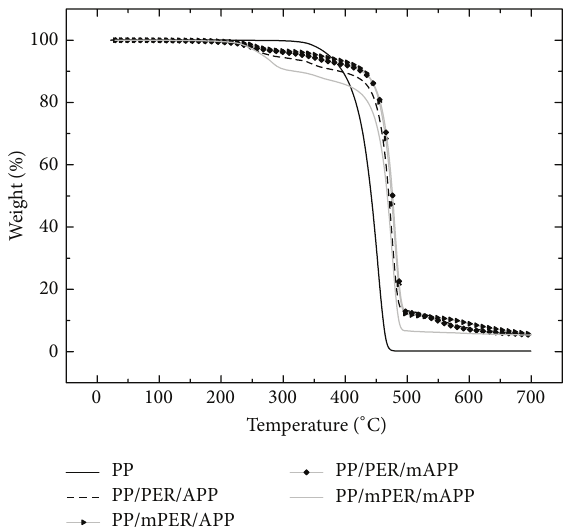
Figure 3: TG curves of neat PP and four intumescent flame retarded PP mixtures containing as-received and milled additives.